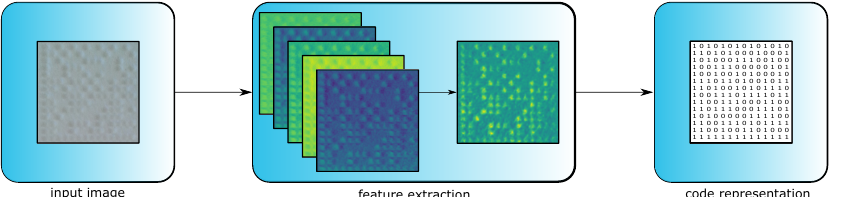
Figure 4. An input image is processed by the encoder model. First, convolutional layers followed by normalization are used to extract multiple features. Here the features are presented as abstract feature maps. The feature maps are aggregated by a last convolutional layer and afterwards, a matrix representation for the code is computed by a fully connected layer combined with a sigmoid